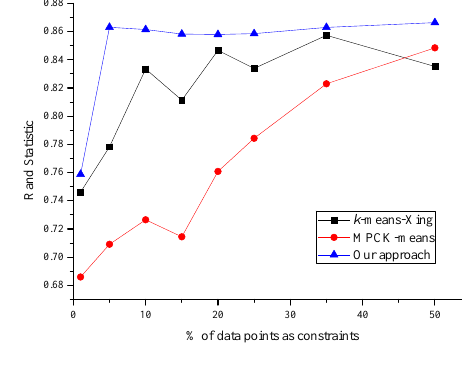
Fig. 4. Clustering accuracy versus constraints on Diabet